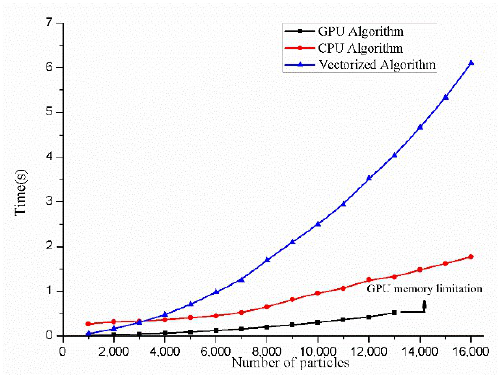
Figure 10. The calculation time comparison of different algorithms.